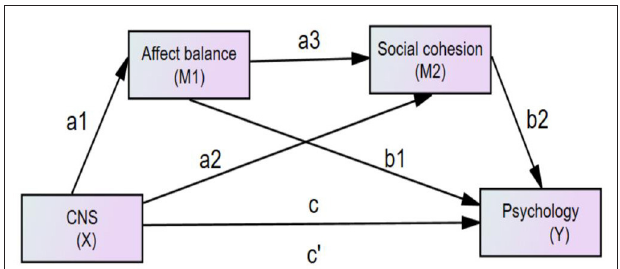
FIGURE 1 | The hypothesized model concerning the relationship between connectedness to nature and psychological adjustment: affect balance and social cohesion as mediators. CNS(X), connectedness to nature; Psychology(Y), life satisfaction or depression; c ′ , the direct effect from X to Y; c, total effect from X to